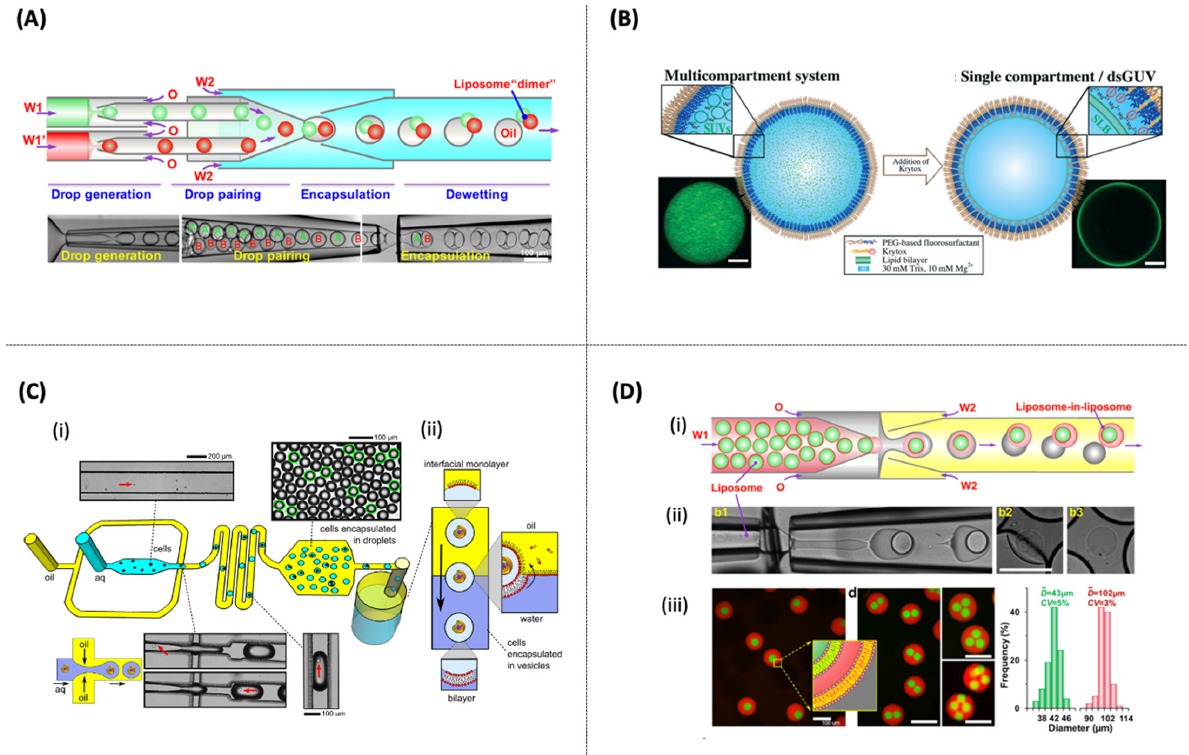
Figure 6. ( A ) Schematic device and images of double emulsions production with two distinct drops [156] ( B ) Charge-controlled microfluidic for the formation of a multicompartmental vesicle. dsGUVs: droplet-stabilized GUVs. Scale bars: 10 μ m [157] ( C ) ( i ) Microfluidic device used to encapsulate cells in w/o droplets encased in a lipid monolayer. ( ii ) Schematic depicting the transformation of cells-in-droplets to cells-in-vesicles [80] ( D ) ( i,ii ) Microfluidic preparation of double emulsions with an inner liposome and the assembly of vesosomes from emulsion dewetting. ( iii ) Confocal images of the monodisperse vesosomes with one, two, three, and four inner liposomes. Size distribution of the inner and outer liposomes of the vesosomes. Scale bars: 100 μ m [159]. Multicompartment synthetic cells have been created to encapsulate SUVs and LUVs in a high-throughput manner. Weiss et al. [149] showed that LUVs (100 nm) and GUVs (15 μ m) and therapeutic cargo could be easily entrapped and released from the cell-like W/O droplet (around 40 μ m in diameter). In this perspective, Haller et al. [157] also showed that SUVs (68 nm) could be easily entrapped into cell-like W/O droplets (around 25 in diameter) (Figure 6B). Weiss and coauthors [149] demonstrated that the encapsu- lated vesicles could be released into the physiological environment by changing their physicochemical and biochemical properties. The authors showed that the pico-injection technique might be coupled to the microfluidic device to load the cell-like compartment with transmembrane and cytoskeletal proteins. In another study, Elani et al. [80] developed a W/O droplet microfluidic device to generate a hybrid cell-in-vesicle system composed of synthetic and cellular modules. These vesicle-based artificial cells are loaded with bioreactor modules such as biological cells (Figure 6C). The microsystem was validated for the encapsulation of bacterium and several eukaryotic cell lines, including Escherichia coli DH5 α , BE colon carcinoma cells, HCT colon carcinoma epithelial cells, and Toledo B lymphocyte suspension cells. Another potential application is shown by Yandrapalli et al. [138], who presented a (W/O/W) high-throughput microfluidic method to produce unilamellar vesicle sizes rang-